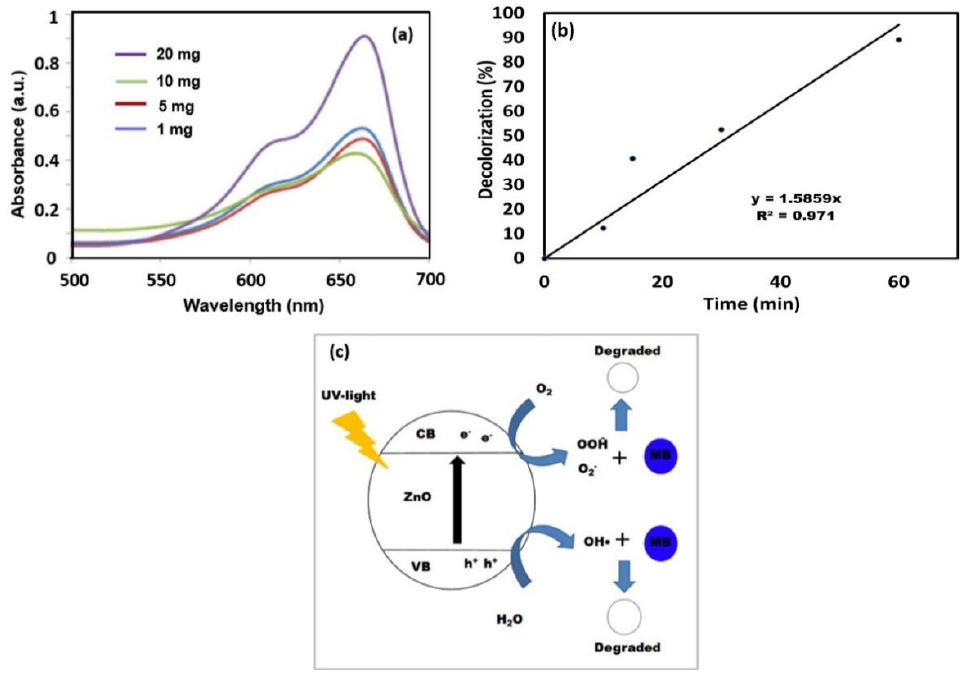
Figure 6. The absorption spectrum of photodegradation efficiency of MB ( a ), degradation percent- age of MB ( b ) and schematic illustration of photodegradation of methylene blue by ZnO NS ( c ). Figure 6c represents the photocatalytic mechanism for MB in the presence of